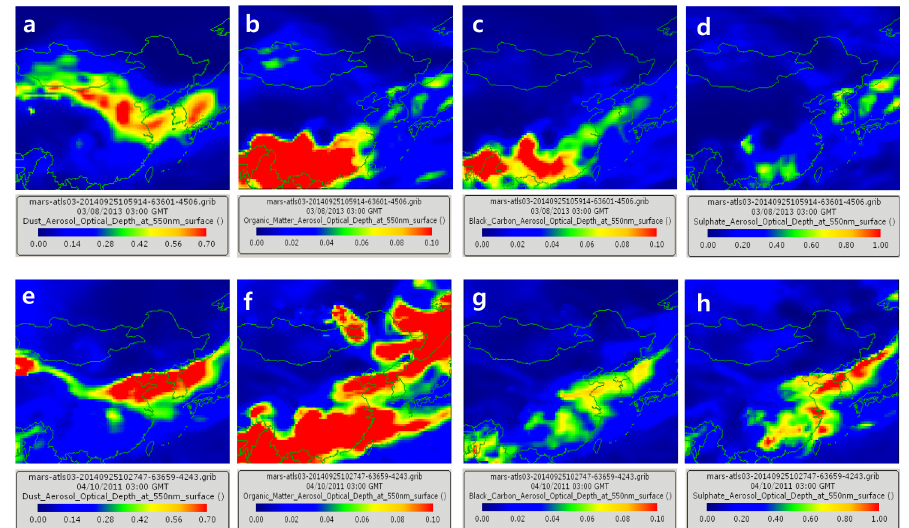
Figure 4. Distribution of AOD at 550nm over East Asia retrieved from ECMWF for (a) and (e) dust, (b) and (f) organic matter, (c) and (g) black carbon, and (d) and (h) sulfate aerosol. (a–d) show 8 March 2013. That day is classified as a relatively less polluted day over eastern China. (e–h) show 10 April 2011, which is classified as a comparably more polluted day over eastern China.